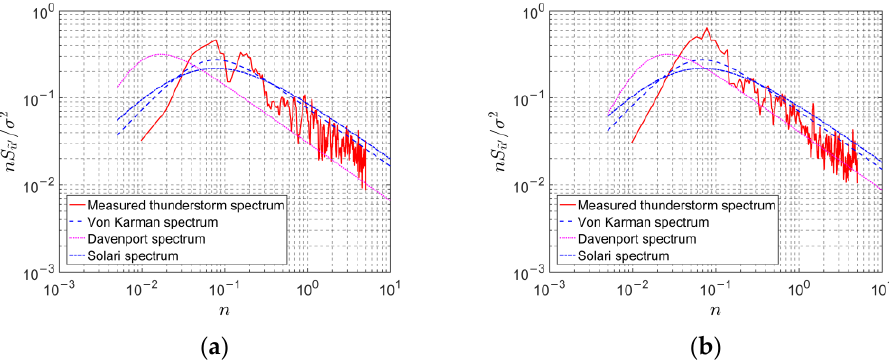
Figure 14. Comparison of PSD of reduced turbulent fluctuation of the thunderstorm at 16 m ( a ) and 64 m ( b ) and empirical models.